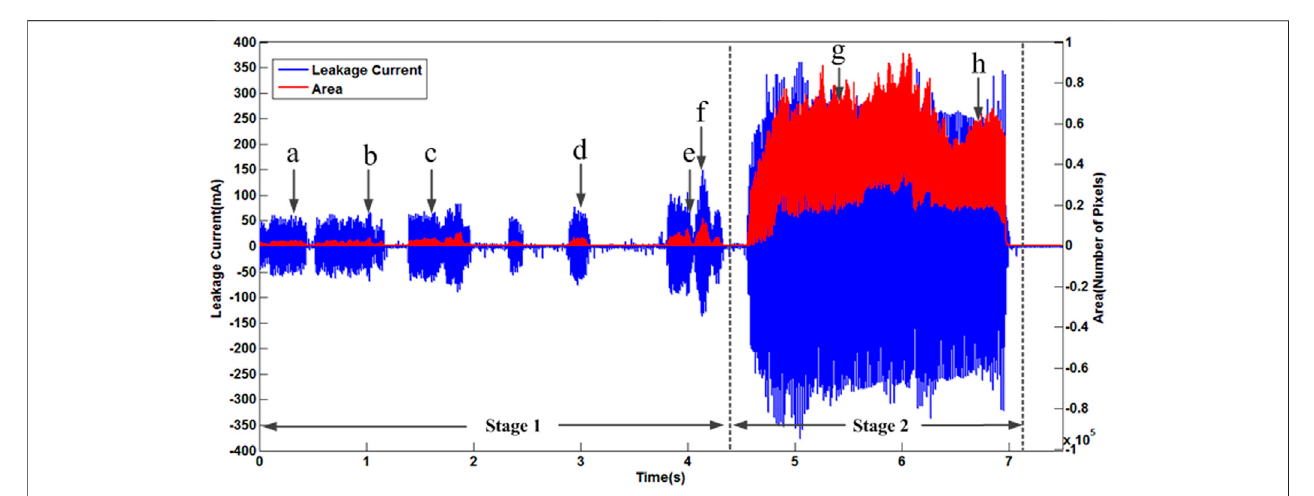
FIGURE 4 | Leakage current and the discharge area.